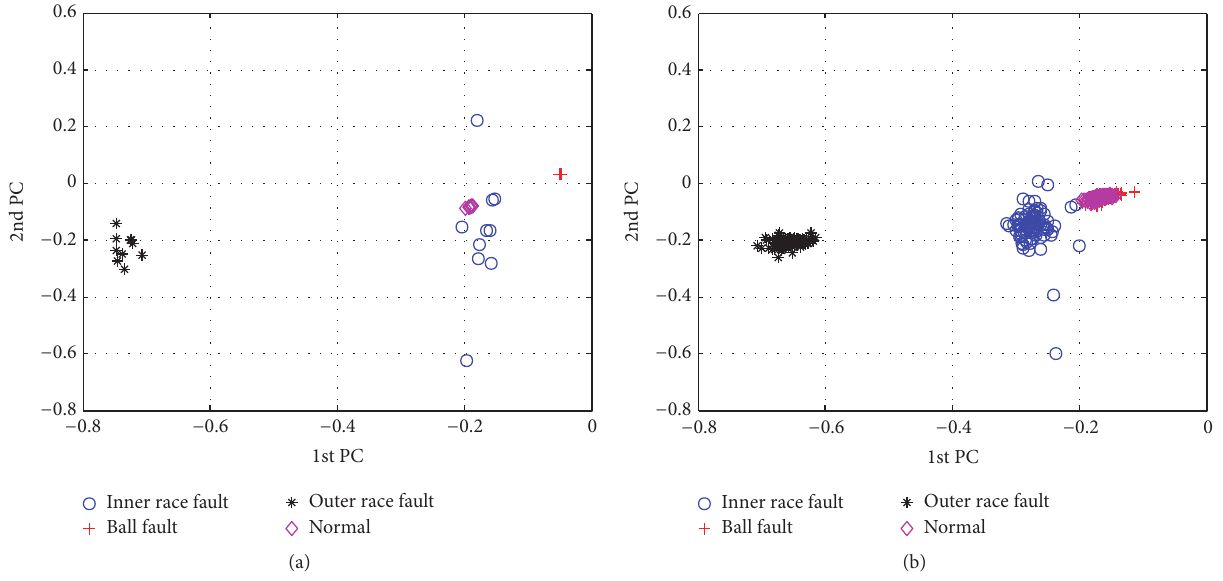
Figure 4: Feature extraction with KMFA: (a) training set and (b) testing set.